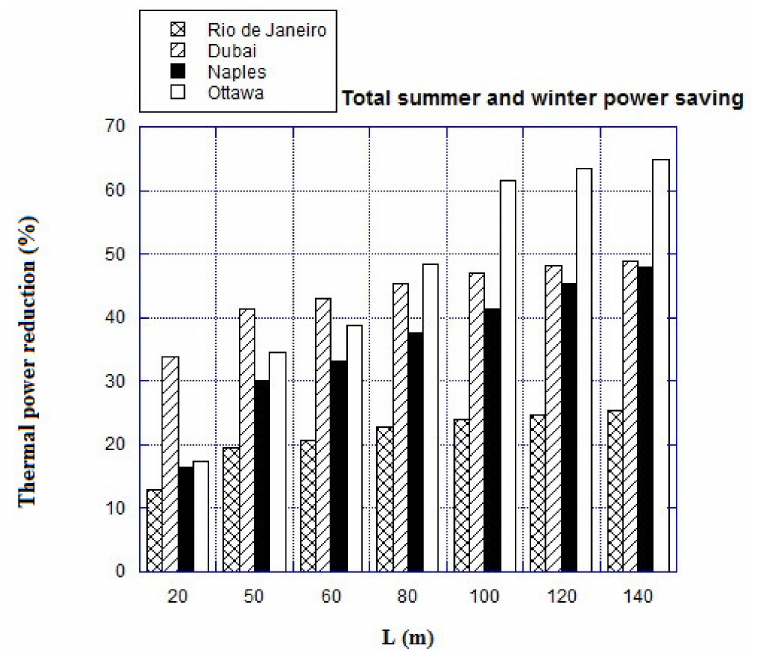
Figure 14. Total power percentage reduction for the coils in the AHU (during winter and summer operation modes) for the four cities by varying the length of the buried pipes of the GAHX and fixing the air flow velocity to 2.5 m s − 1